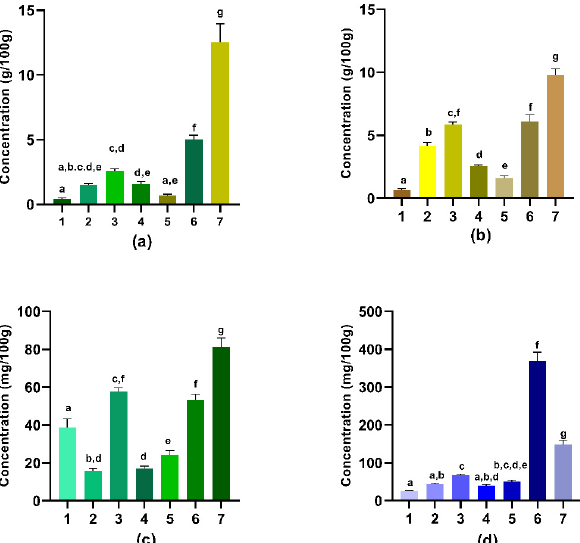
Figure 2. Macronutrients of the edible plant organs from Solanum nigrescens ( 1 ), Sechium edule ( 2 ), Rumex obtusifolius ( 3 ), Amaranthus hybridus ( 4 ), Piper auritum ( 5 ), Rhamnus pompana ( 6 ), and Yucca aloifolia ( 7 ). The content of protein ( a ), fiber ( b ), fat ( c ), and reducing sugars ( d ) is shown. Different letters indicate means ( n = 10) with statistically significant differences by ANOVA–Tukey’s test at p < 0.05. Detailed information can be found in Table S1.